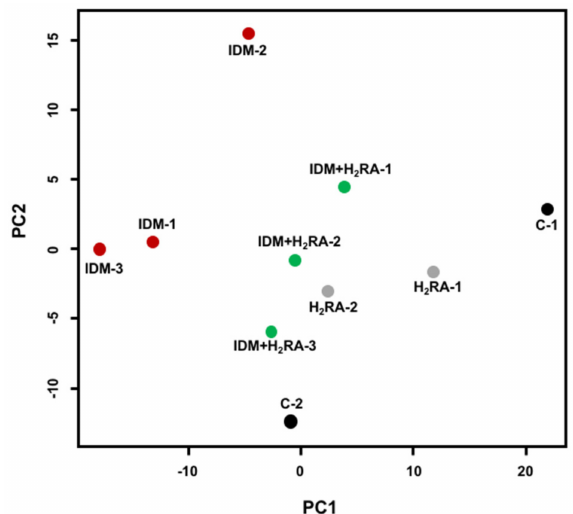
Figure 4. Conversion to 2D chart of intestinal flora classification in the feces of Indometacin (IDM)-induced intestinal mucosal injury model with or without histamine H 2 -receptor antagonists (H 2 RA) administration. Based on the data of the area ratio of peaks for bacterial taxa (Figure 3), analysis was performed using principal coordinates analysis (PCoA). The final number indicates the individual mouse